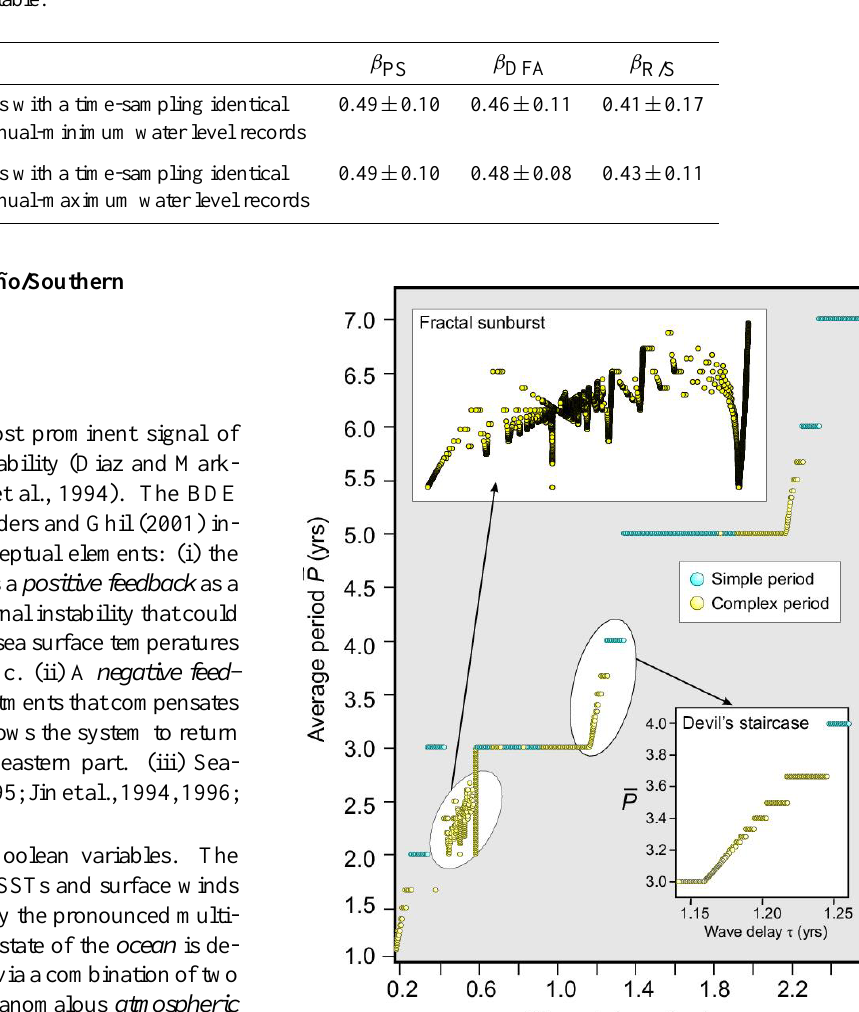
Fig. 9. Devil’s staircase and fractal sunburst: A bifurcation diagram showing the average cycle length ¯ P vs. the wave delay τ for a fixed β = 0 . 17. Blue dots indicate purely periodic solutions; orange dots are for complex periodic solutions; small black dots denote aperiodic solutions. The two insets show a blow-up of the overall, approximate behavior between periodicities of two and three years (“fractal sunburst”) and of three and four years (“Devil’s staircase”). Modified after Saunders and Ghil (2001).